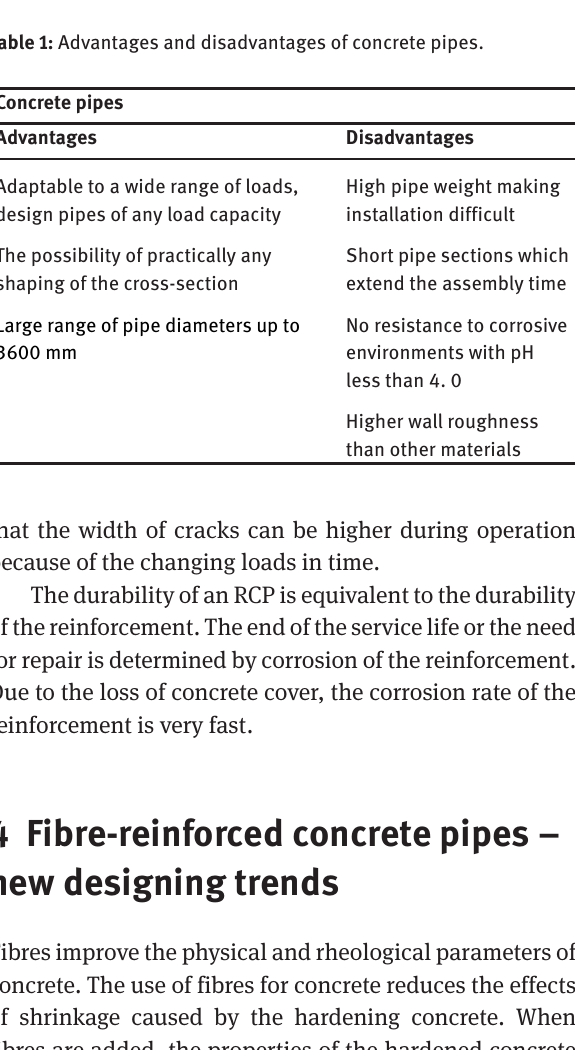
Figure 1: Concrete corrosion mechanism